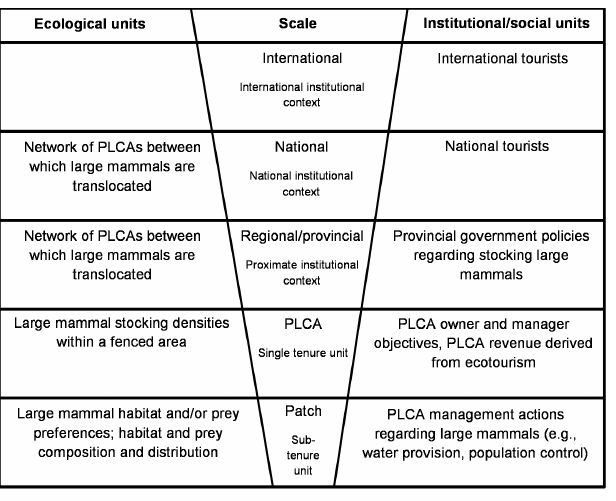
Fig. 1 . Summary of multiscale socioecological patterns and processes related to large charismatic mammal management on private land conservation areas (PLCAs), based on the protected area framework presented in Cumming et al. (2015) and Maciejewski et al. (2015). Each unit represents both a spatial scale (akin to traditional ecological spatial scales [Poiani et al. 2000]) and an institutional